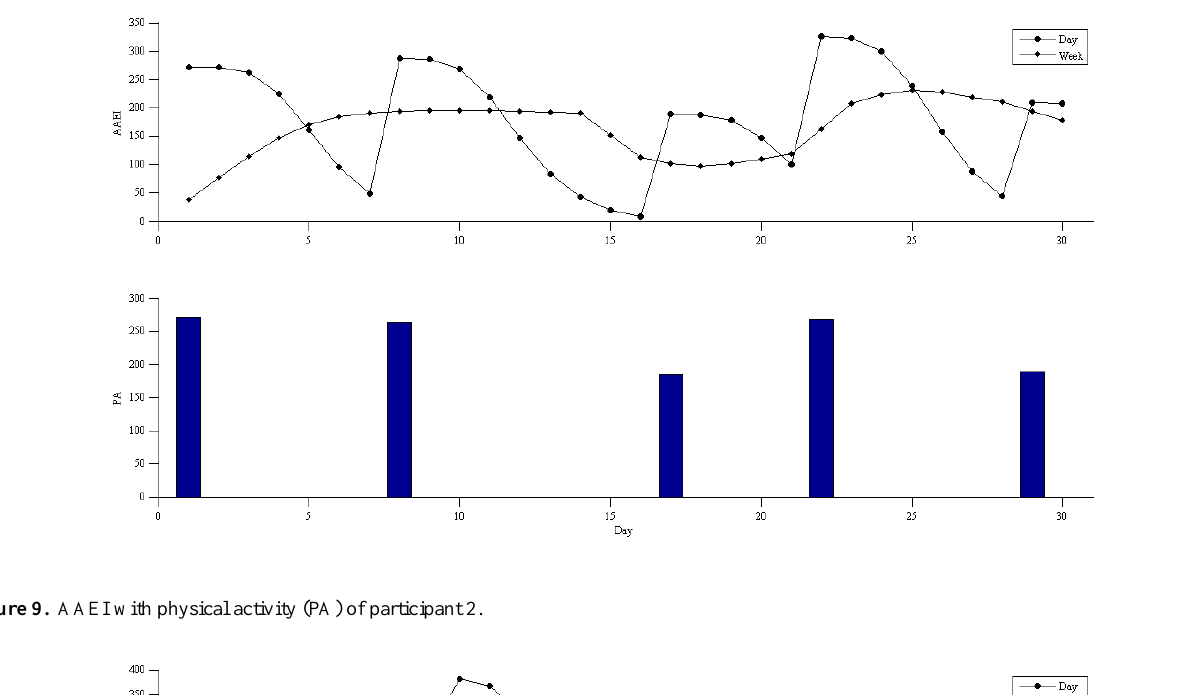
Figure 8. AAEI with physical activity (PA) of participant 1.